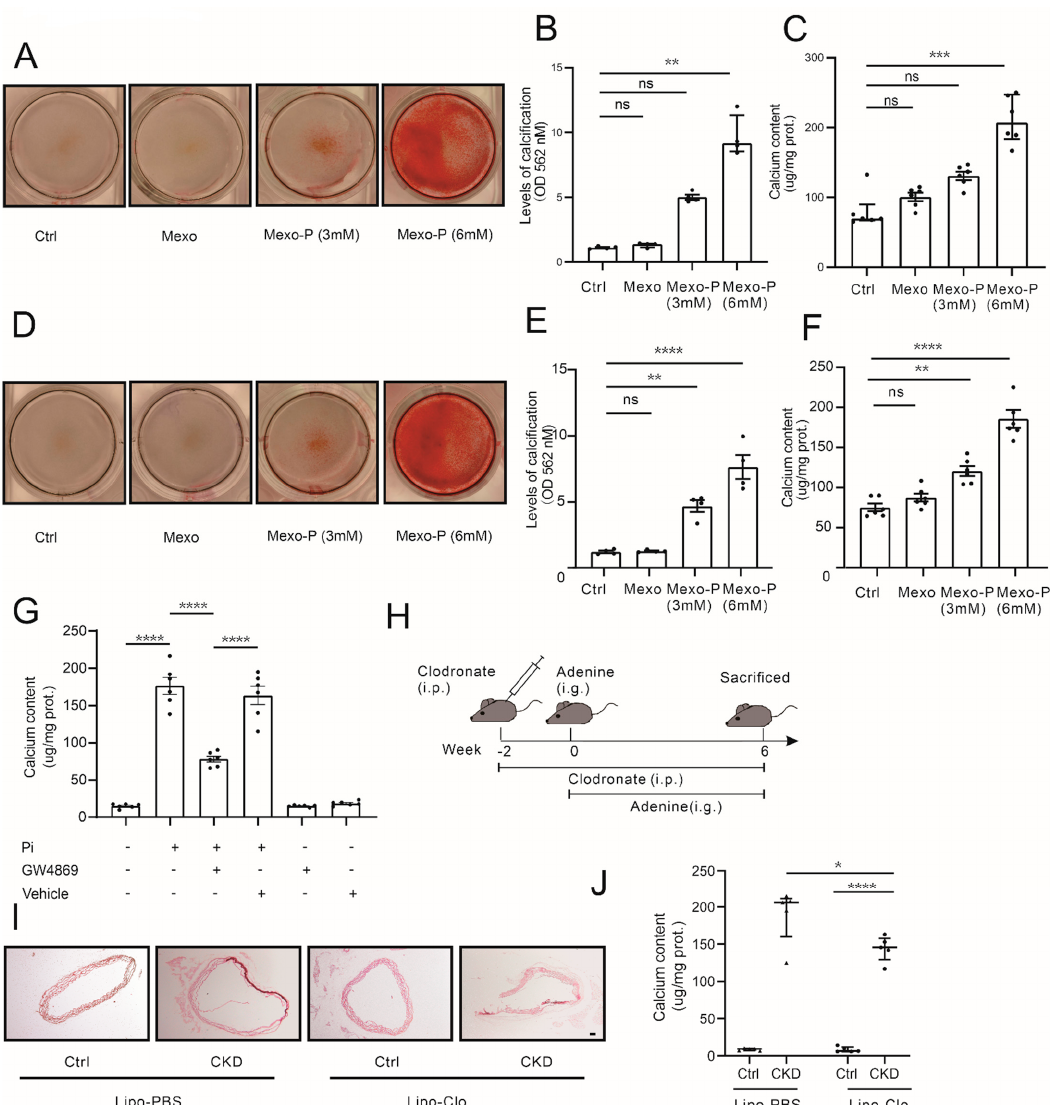
Figure 2. High-phosphate-stimulated macrophages releasing exosomes promote vascular calcification. Representative images of ARS staining ( A ), ARS quantification ( B ), and calcium content ( C ) of MOVAS treated with the calcifying medium in the presence or absence of Mexo derived from macrophages pretreated with different doses of phosphate (0, 3, 6 mM) (Kruskal–Wallis test, n > 3). Representative images of ARS staining ( D ), ARS quantification ( E ), and calcium content ( F ) of HASMCs treated with the calcifying medium in the presence or absence of Mexo derived from macrophages pretreated with different doses of phosphate (0, 3, 6 mM) (one-way ANOVA, n > 3). ( G ) Calcium content of HASMCs co-cultured with macrophages, in the presence or absence of 3 mM Pi or 20 uM GW4869 (one-way ANOVA, n = 6). ( H ) Schematic diagram of clodronate-liposome-induced macrophage depletion in adenine-induced CKD mouse model. ( I ) Representative images of ARS staining ( I ) and calcium content ( J ) of thoracic aortas of control or CKD mice treated with clodronate (Lipo-Clo) or control liposomes (Lipo-PBS) (Mann–Whitney test, n = 5). * p < 0.05, ** p < 0.01, *** p < 0.001, **** p < 0.0001, n.s. not significant. Scale bar, 40 µ